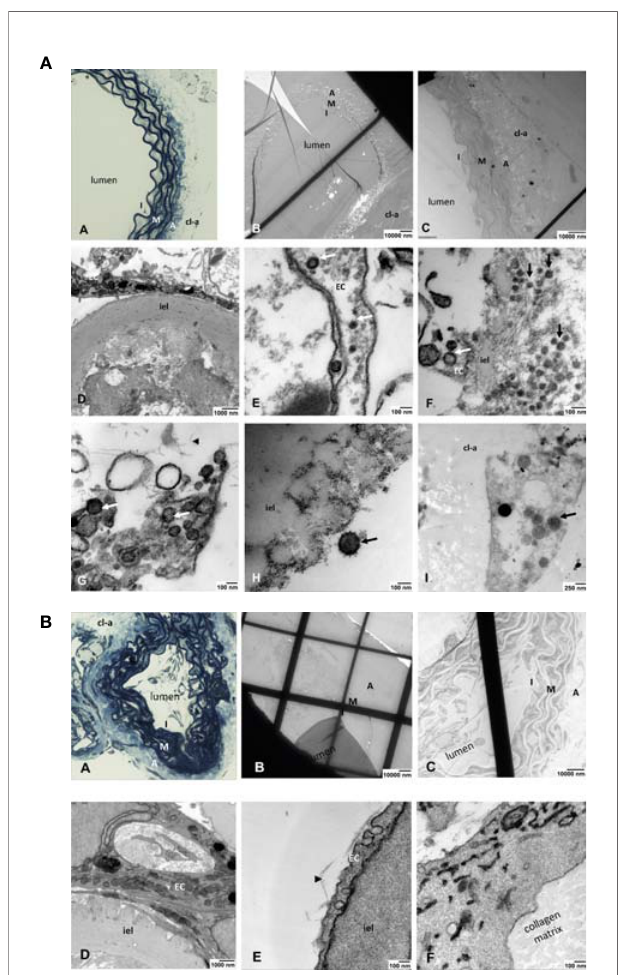
FIGURE 5 | (A) Light and electron microscopic analyses of SARS-Cov-2- infected ARA. (A) toluidine blue-stained aortic wall section displaying the layers intima (I), media (M) and avdentitia (A) . (B) Tissue section of SARS- CoV-2-infected ARA in EM with low and (C) higher magni fi cation displaying the aortic wall layers as in (A). (D) Higher magni fi cation shows the aortic intima with EC and inner elastic lamina (iel) (E – I) SARS-CoV-2 viral particles (arrows) in a EC process into the aortic lumen (E) , in the intimal layer (arrows) (F) , inside of an EC process within the collagen matrix (arrowhead) (G) , attached to the inner elastic lamina (iel) (H) , in a cell that was migrated into the collagen gel (cl-a) around the aortic wall (I) . I: intima, M: media, A: adventitia; EC: endothelial cell; cl-a: collagen gel around the aortic wall; iel: inner elastic lamina of the aortic wall. (B) Light and electron microscopic analyses of non-infected ARA. (A) Toluidine blue-stained aortic wall section displaying the layers intima (I), media (M) and adventitia (A) . (B, C) tissue section of non-infected ARA in EM with low and higher magni fi cation displaying the aortic wall layers as in A. (D – F) : No SARS-CoV-2 viral particles were detected in the cells of the aortic wall, neither in ECs of the intima (D, E) nor in those sprouted into the collagen matrix (F) . I: intima, M: media, A: adventitia; cl-a: collagen gel around the aortic wall; iel: inner elastic lamina of the aortic